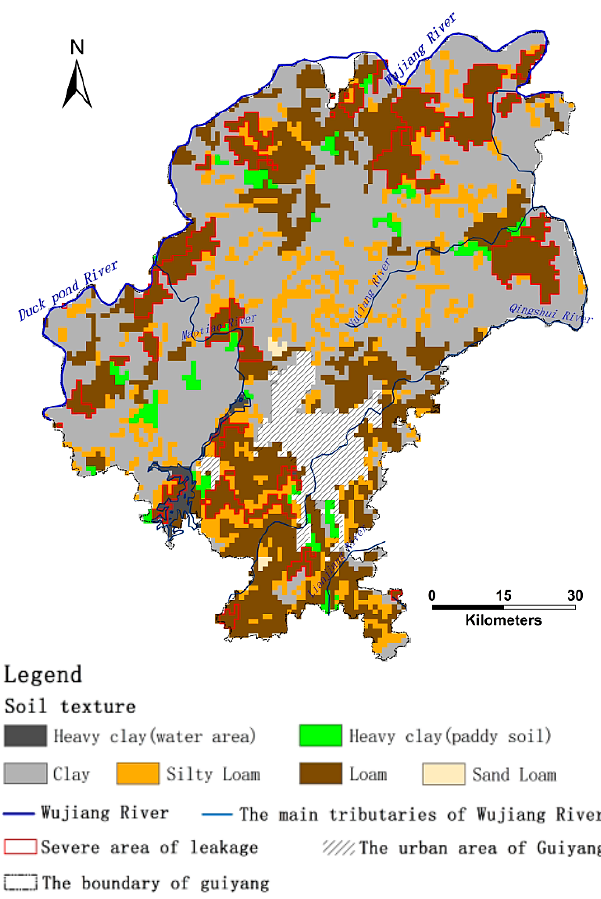
Figure 5. The distribution of soil texture in the environs of Guiyang.